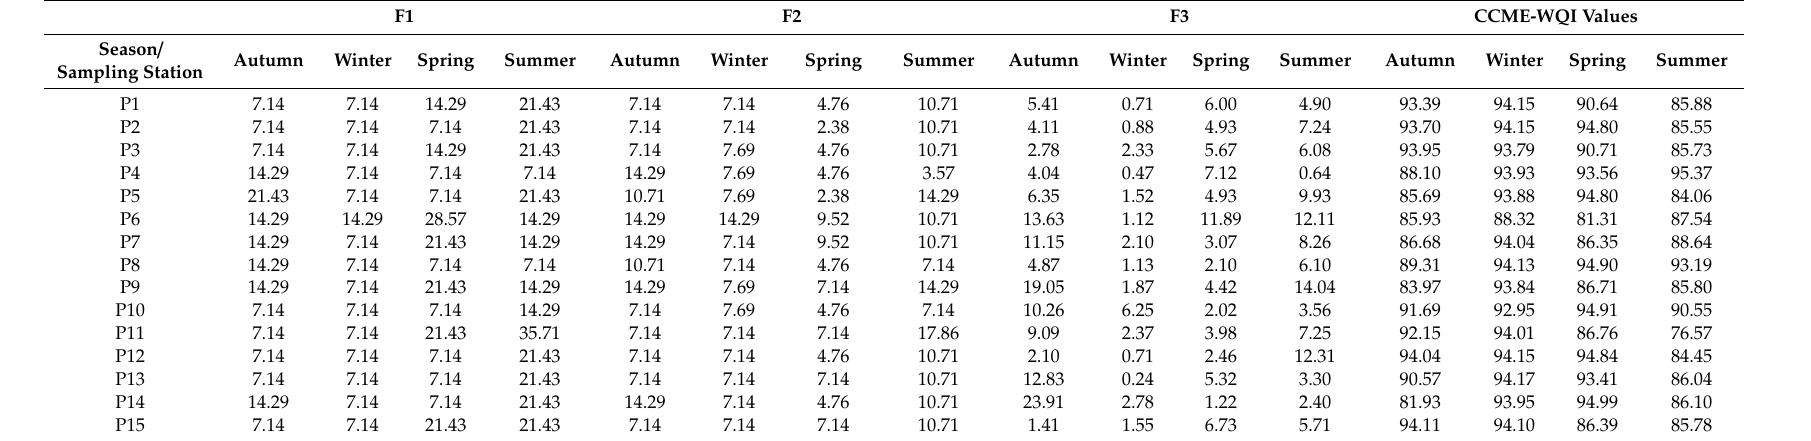
Table 7. Temporal and spatial variation of F1, F2, F3 and CCME-WQI values. F1 F2 F3 CCME-WQI Values